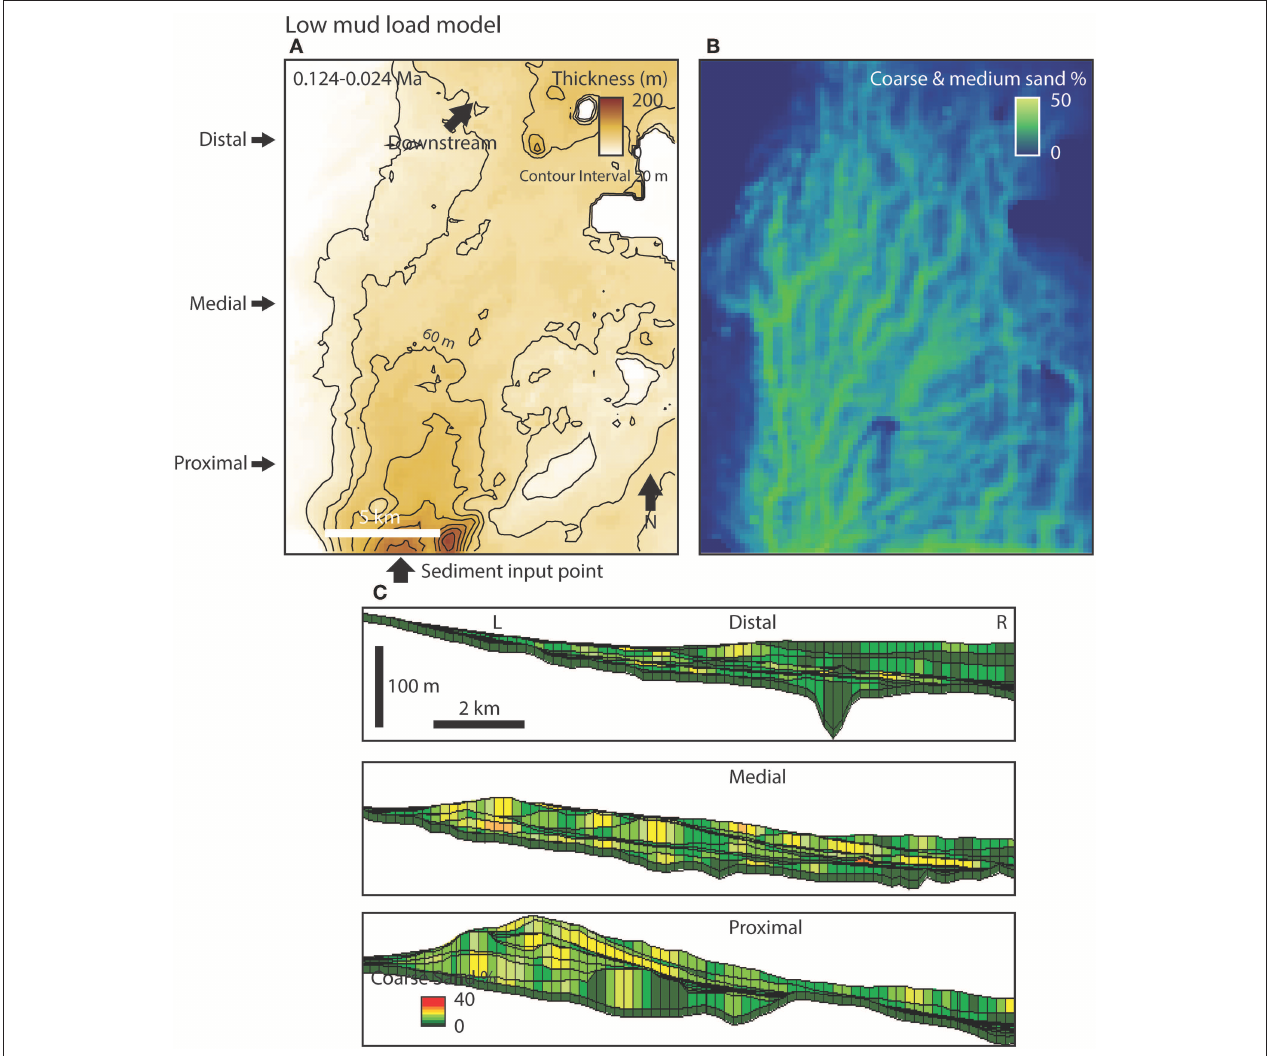
FIGURE 6 | (A) Isochore map of the low mud load model. (B) Coarse and medium sand percentage within the model. (C) Proximal, medial, and distal cross sections showing the coarse sand content in the model. Left (L) and right (R) orientations in cross sections are left and right in maps. Cross-section locations are indicated in part (A)